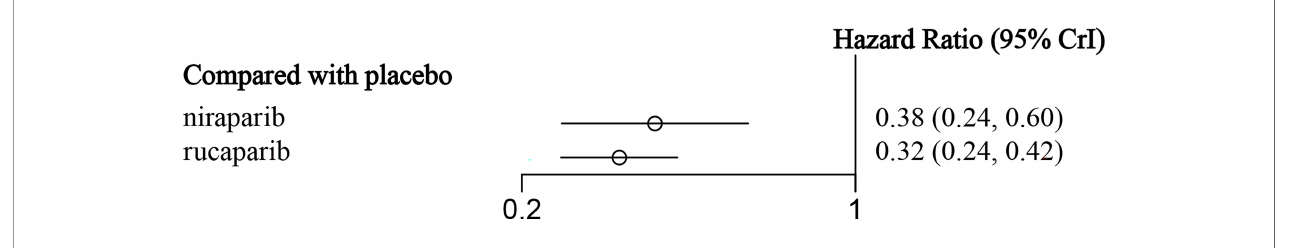
FIGURE 7 | The forest plot of PFS in HRD-positive patients.